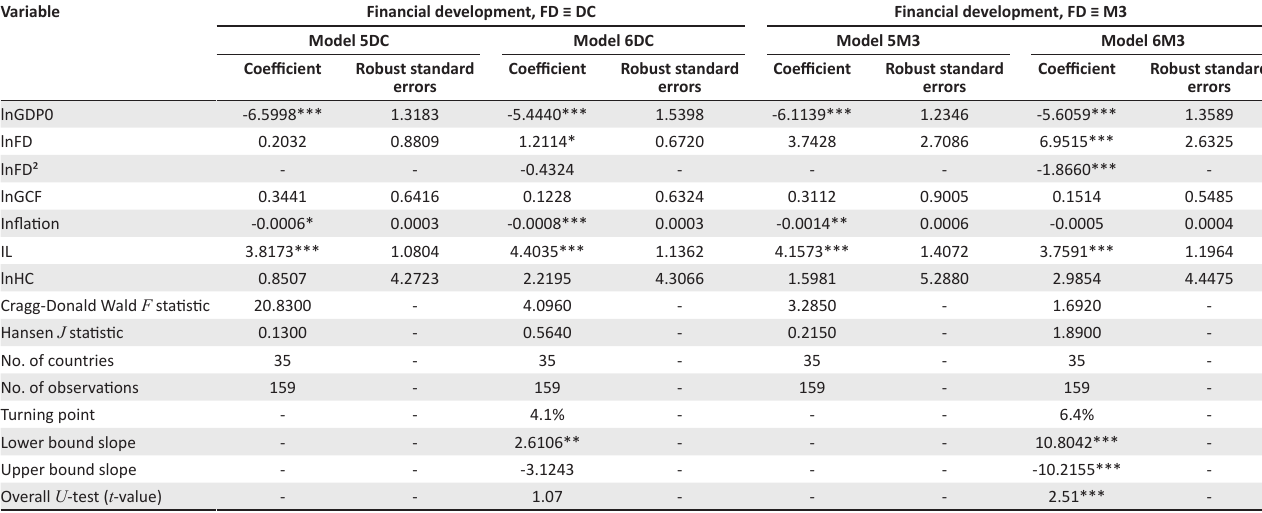
TABLE 1-A1: Generalised method of moments instrumental variables